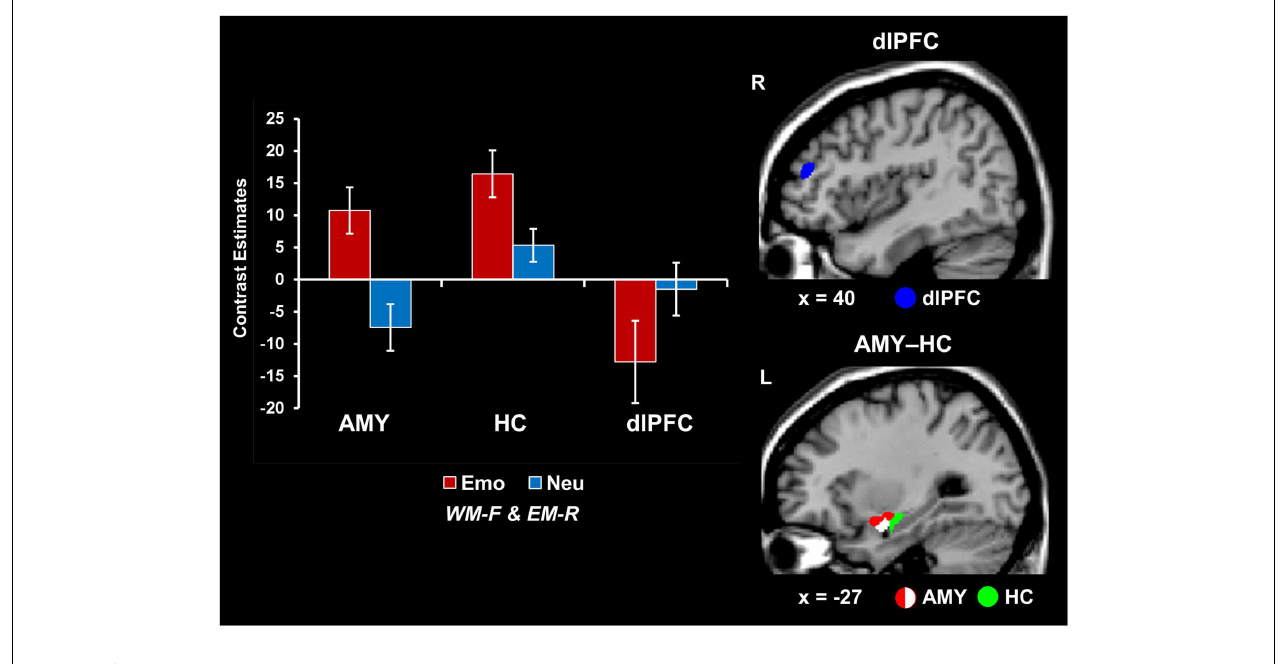
FIGURE 2 | Opposing patterns of activity inAMY and HC vs. PFC linked toWMI and EME effects of emotion . Increased activity in both AMY (red blob) and HC (green blob) and greater deactivation in the dlPFC (MFG, BA46; blue blob) were observed in response to emotional relative to neutral distracters that impairedWM performance and were later remembered (i.e., Emo WM-F and EM-R > Neu WM-F and EM-R , for activity in the ventral and Neu WM-F and EM-R > Emo WM-F and EM-R for activity in the dorsal systems). A negative correlation was also identified between left AMY activity andWM performance to emotional distracters (white blob; see Results).The bar graphs show